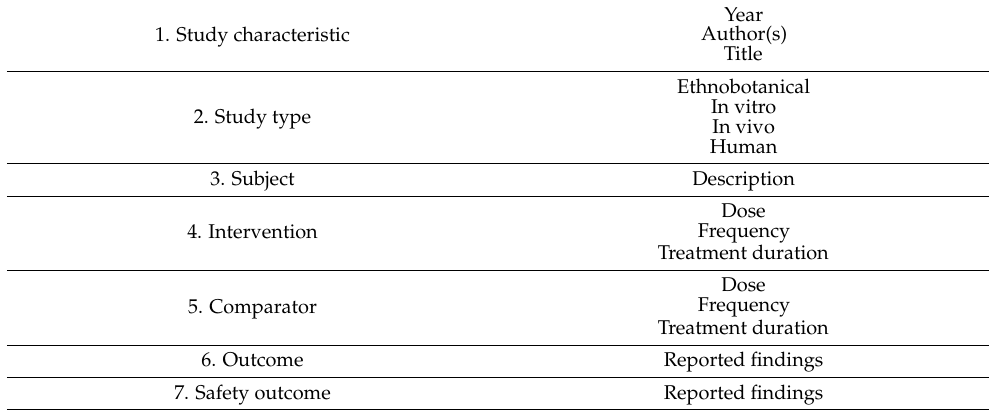
Table 1. Template of data to be extracted for the conduct of this scoping review.